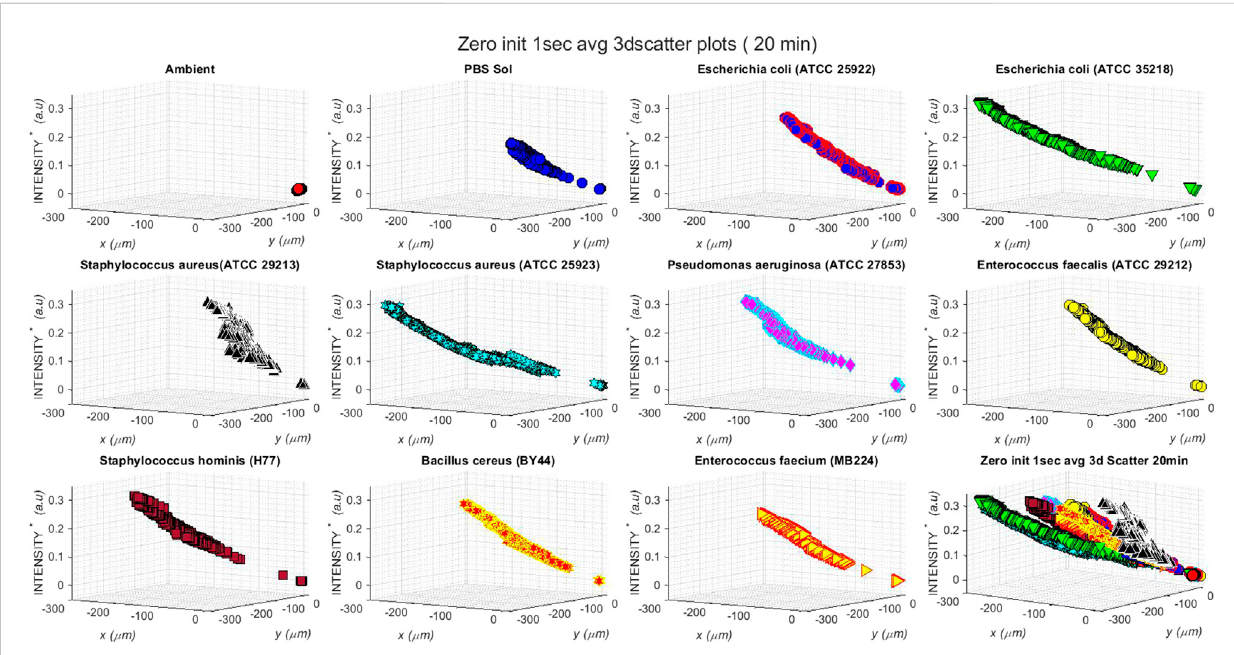
Three-dimensional scatter plots of backscattered light detected by the photodetector of AUM photonic system when aerosols laden with PBS solutionanddifferentbacterialsampleswereinjectedintotheinterrogationvolumeoflightscattering.Theplotsshowrelativechangesin x,y positions(in µm ) ofthe backscattered beam and intensity (in au )ofbackscattered beam, time averaged every 1 s),from theoriginaldata for eachtrial run. The original datahad12,00,000points,andthe1- s timeaverageddatahas1,200pointsforeachtrialrun.Alltrialswererepeatedtwiceandcheckedforrepetivity of